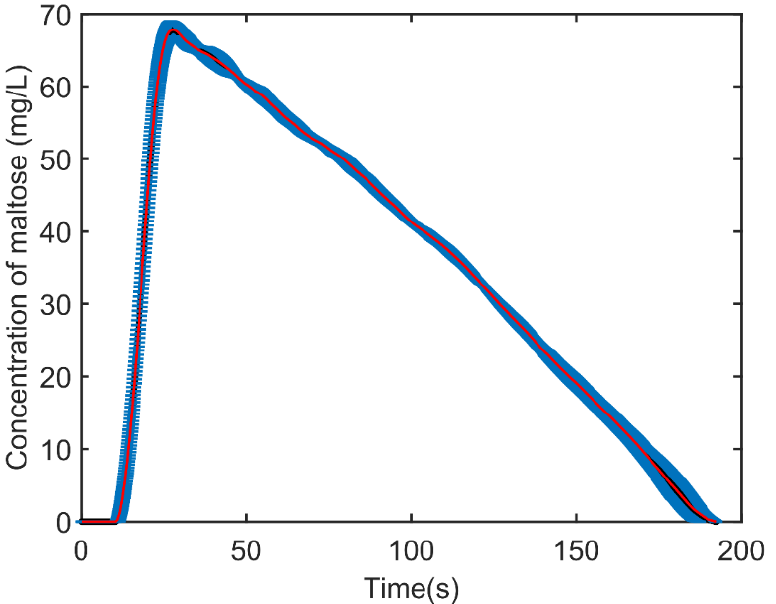
Figure A2. Concentration of maltose over time for the initial cleaning experiments.